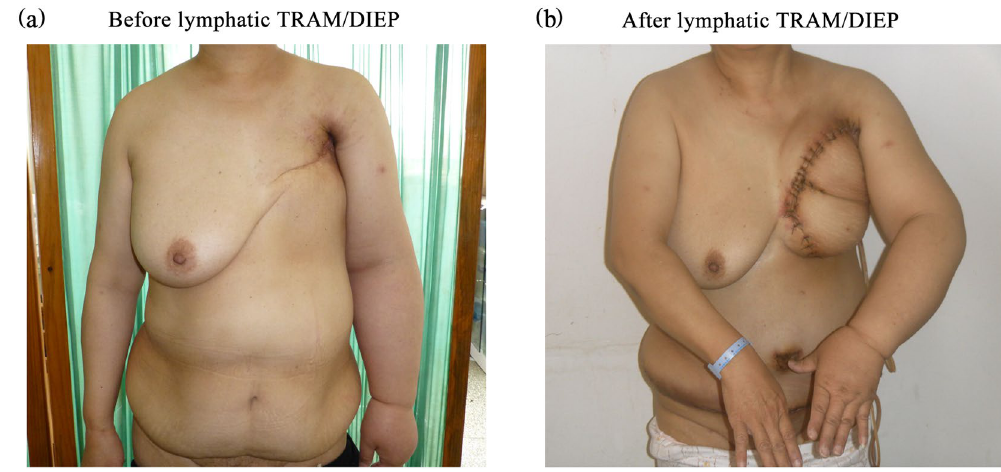
Figure 1. Preoperative evaluation and postoperative 2-week evaluation. ( a ) Preoperative status before lymphatic TRAM/DIEP. ( b ) Postoperative 2-week